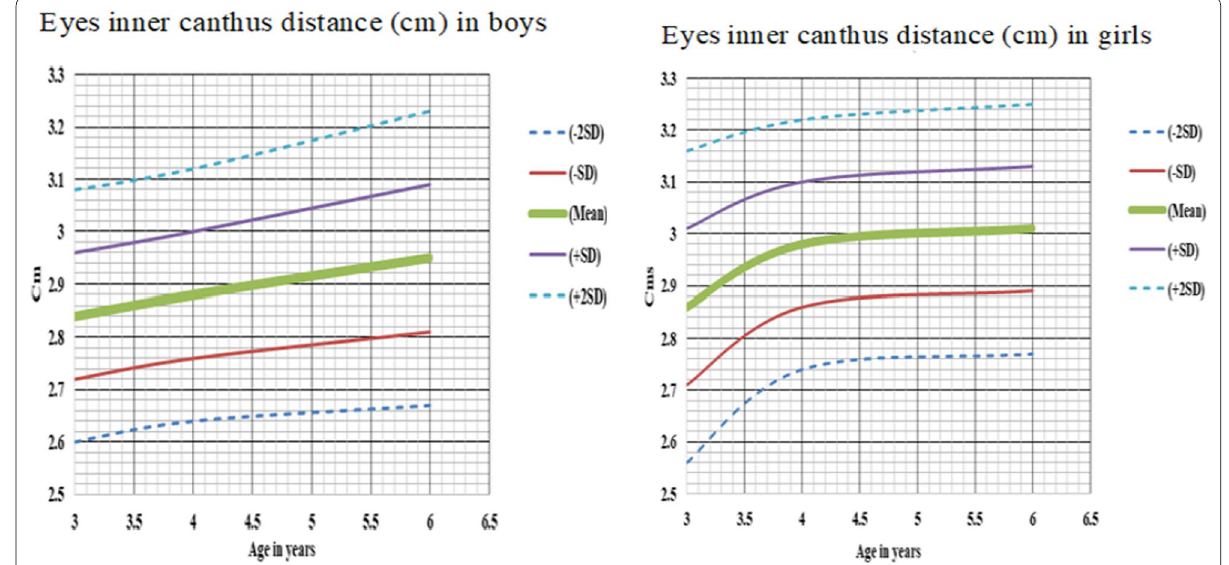
Fig. 2 Eyes inner canthus distance (cm) in boys and girls